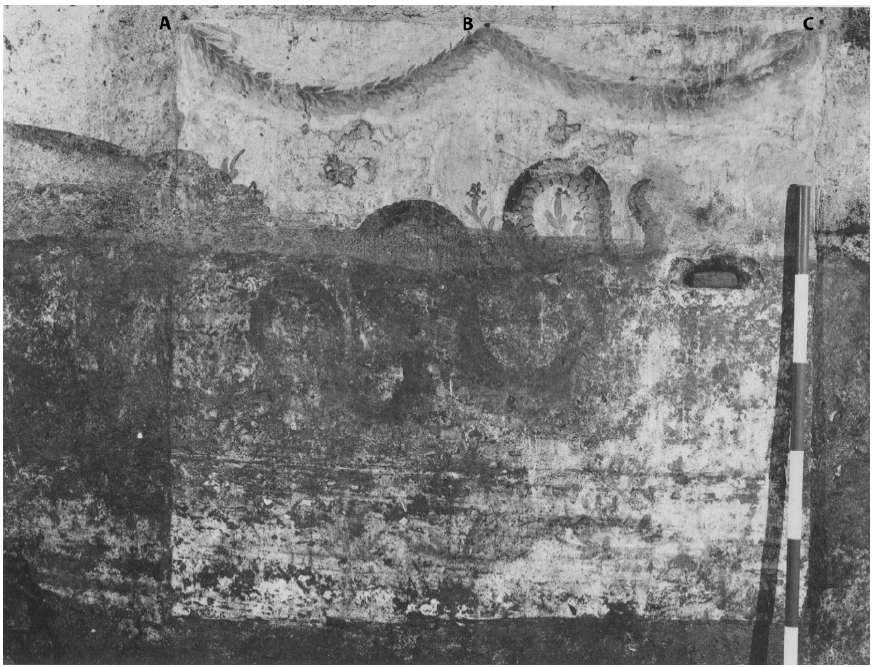
Figure 6. Casa dei Capitelli Colorati (7.4.31.51), Pompeii. Snake approaching an altar. Indications for